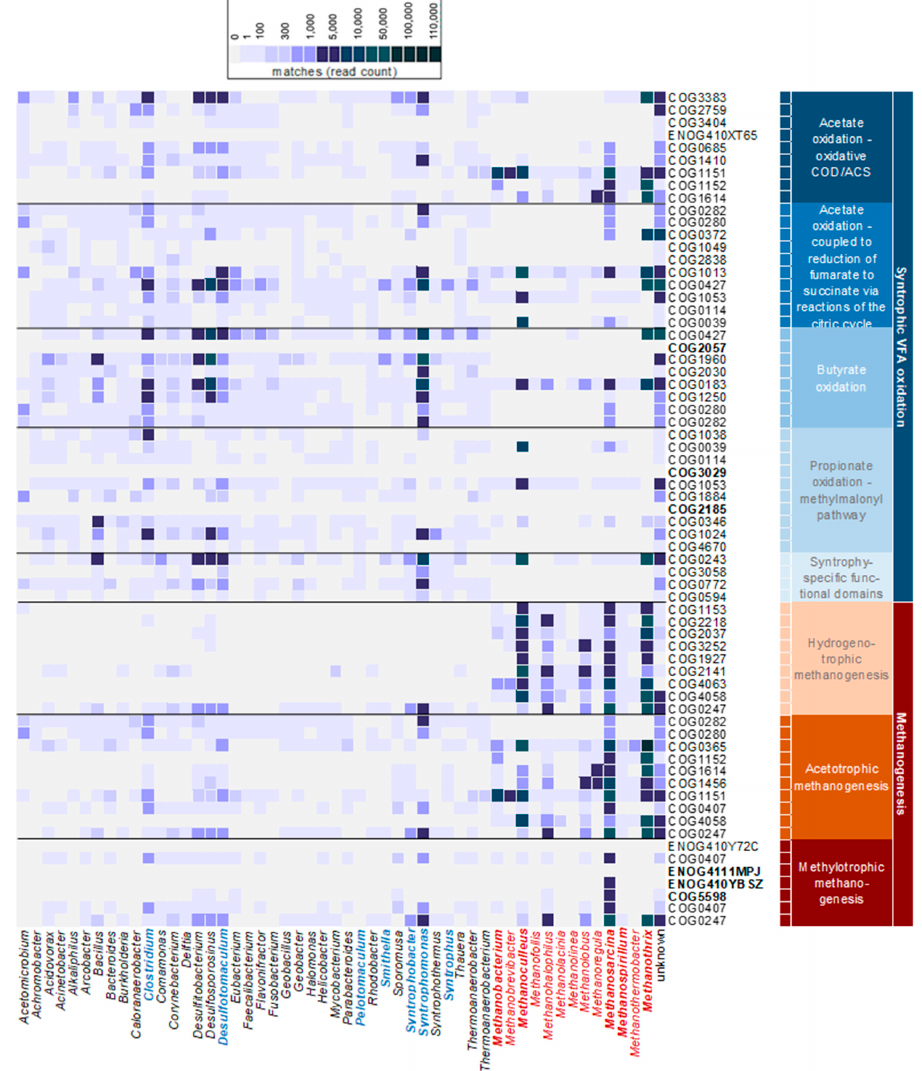
Figure 2. Taxonomic and functional annotation of metagenome reads. Rows contain pathway- specific genes for propionate, butyrate, and acetate degradation as well as methanogenesis pathways. The color gradient represents read abundance (read counts per genus and potential function as absolute values). Genera with most matches for the selected pathways are shown. IDs in bold indicate alternatives to searched gene IDs, or were not available (see Supplementary File S1). Genera indicated in blue were associated with SCFA oxidation pathways and genera indicated in red with methanogenesis pathways. The “unknown” section represents all reads that were not assigned to any known organism in the NCBI